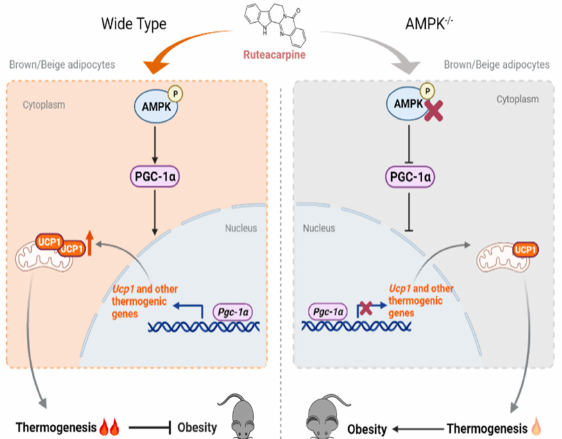
Figure 8. Graphical abstract. In this study, we revealed the effects of rutaecarpine (Rut) on thermo- geneis and weight management. Rut can reduce adiposity, improve insulin resistance and increase respiratory activity in mice with HFD-induced obesity. The mechanism of the effects of Rut involved AMPK/PGC-1 α pathway, and we demonstrated that AMPK deficiency in adipose tissue suppressed the upregulation of thermogenic markers and beneficial metabolic effects in Rut-treated